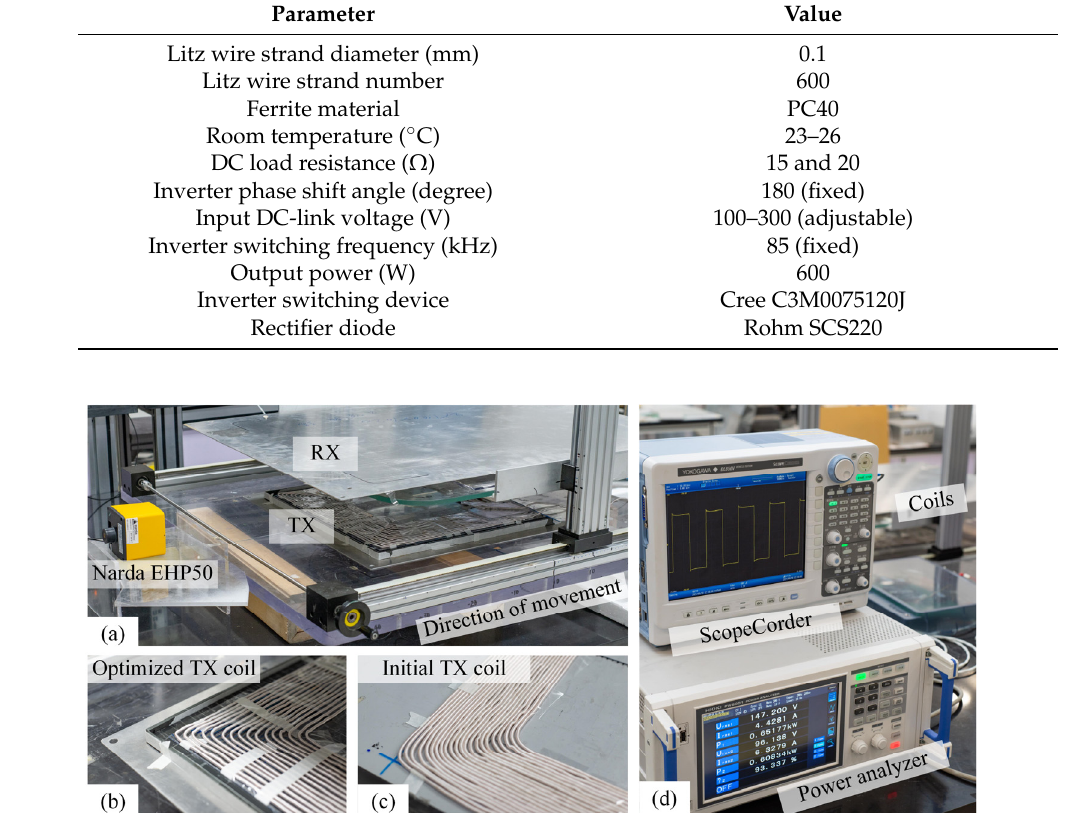
Figure 9. Experimental setup. ( a ) Coil assembly pair and magnetic field analyzer. ( b ) Optimized TX coil. ( c ) Initial TX coil. ( d ) Measurement of power, efficiency and the inverter’s output